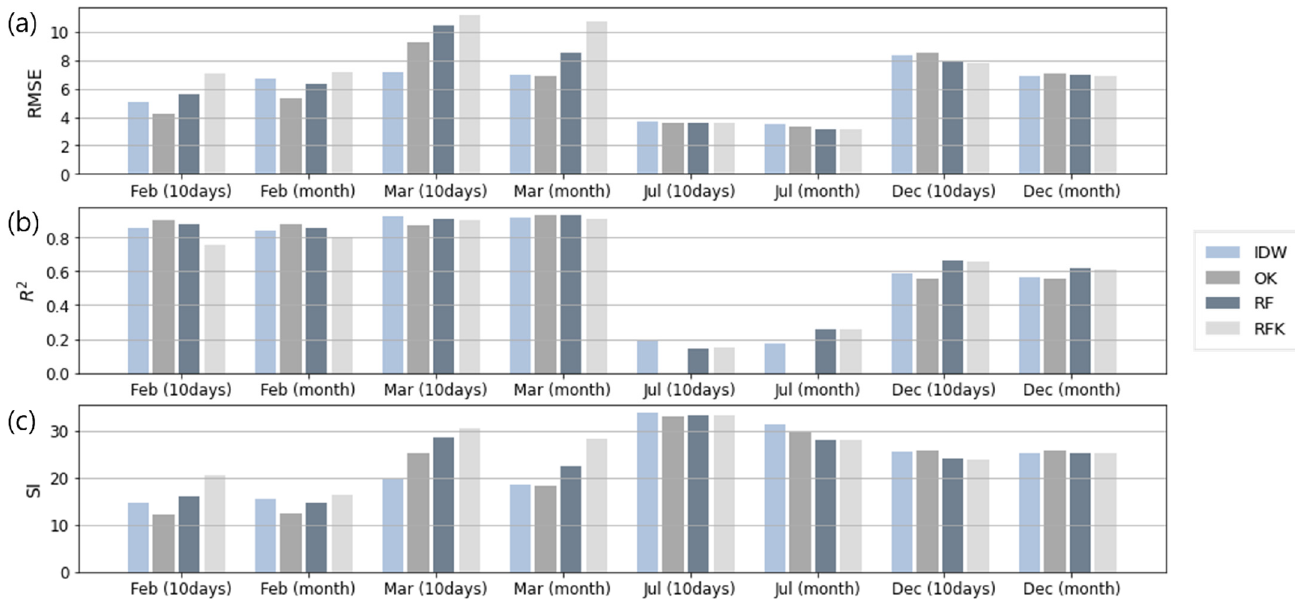
Figure 8. Ten-fold cross-validation results of ( a ) RMSE, ( b ) R 2 , and ( c ) SI from different spatial interpolation methods for each scenario.